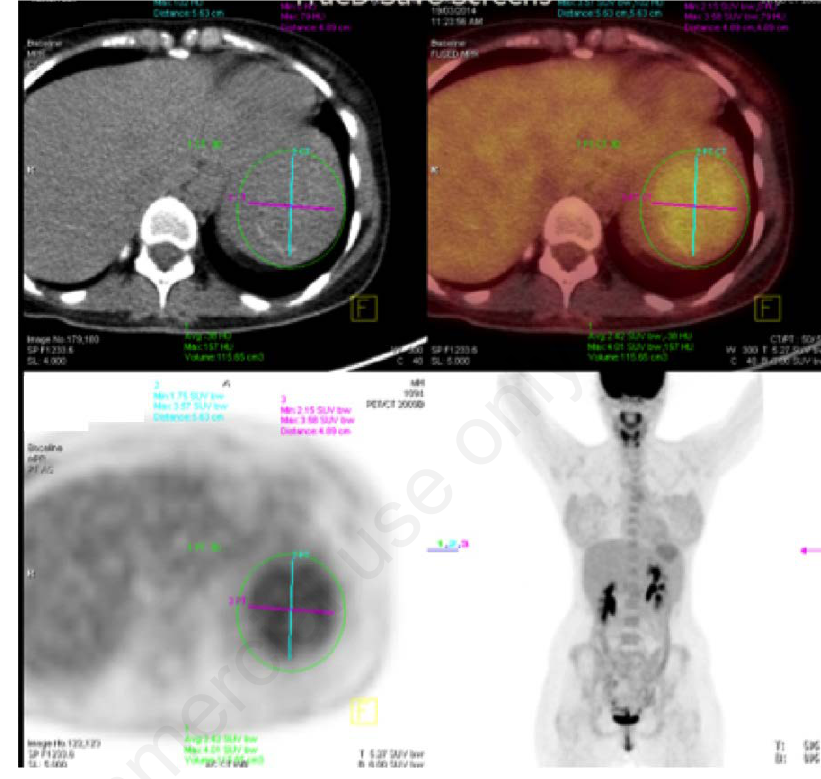
Figure 1. Positron emission tomography-computed tomography (PET-CT) scan of the abdomen highlighting a lesion with mild fludeoxyglucose-18 uptake on the superior pole of the spleen on PET, with CT verification of a heterogeneous lesion with an area of cal- cification.